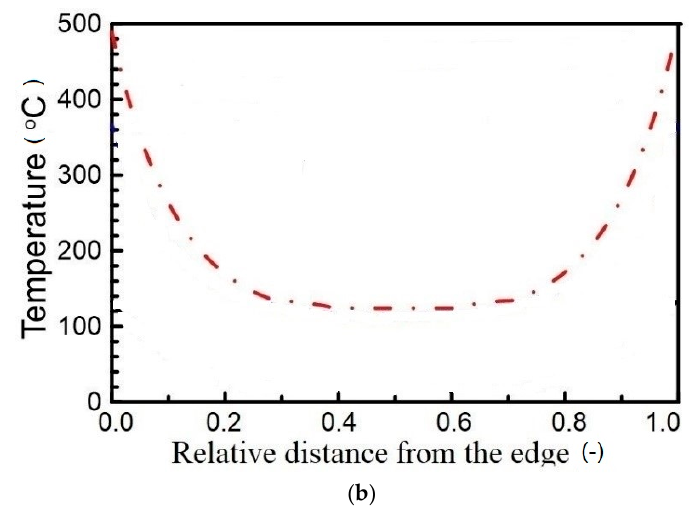
Figure 10. ( a ) Decomposition of the heat flow as a function of time along the Cartesian directions (x, y, z) at measuring point 1: ( b ) Transversal temperature profile at the final stage of the fire test (60 min) along the line passing through measuring point 5 (see black line in Figure 1b). Door characteristics: 117 mm width, 2117 mm height, steel sheet of 5.0 mm and 1.5 mm for the exposed side with rock-wool, 60 mm thick, and 180 kg m -3 density as insulator. Adapted from [14].